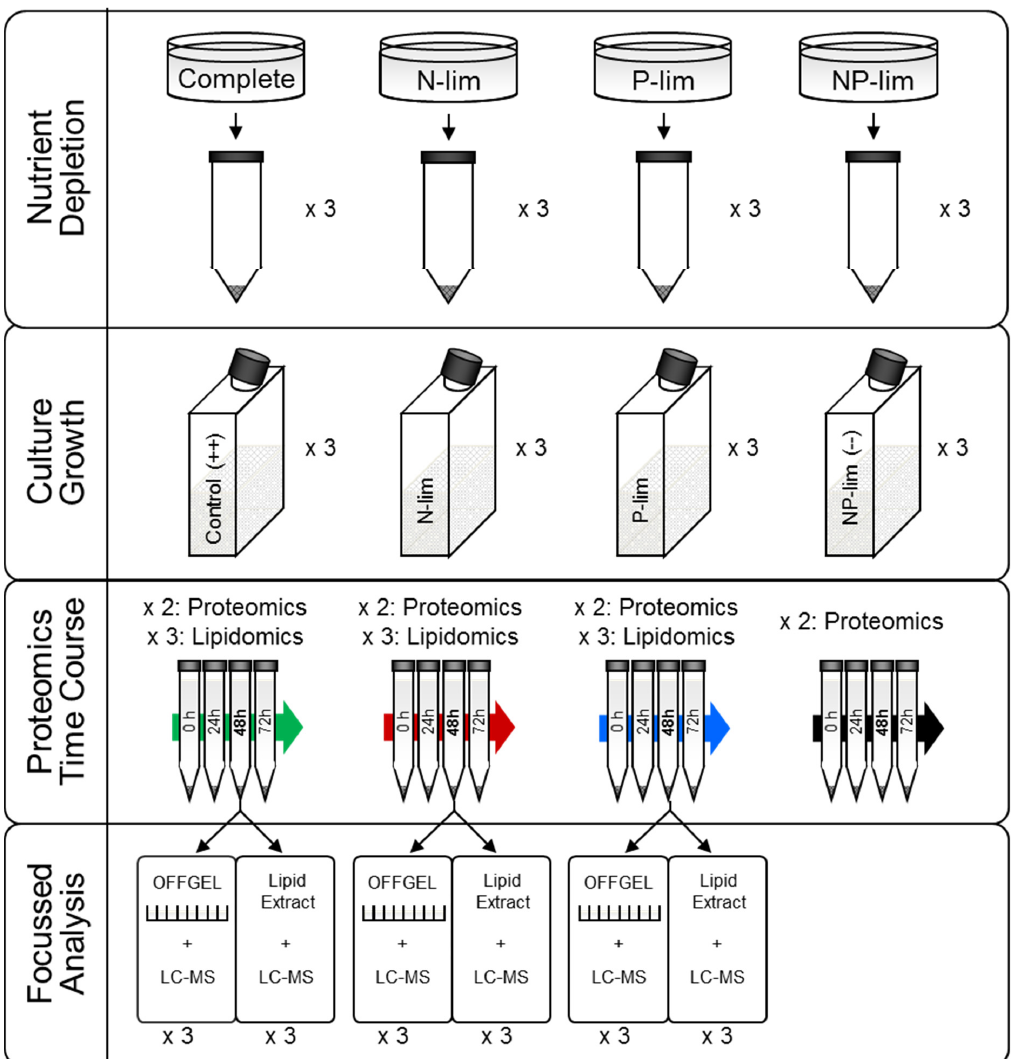
Figure 6. Experimental workflow for proteomic and lipidomic profiling of O. tauri under nutrient stress. Cultures were grown in complete media, media lacking nitrogen sources (N-dep), media lacking phosphorus (P-dep) or media lacking both nitrogen and phosphorous (NP-dep). Algae were sampled at t = 0, 24, 48 and 72 h and shotgun proteomics was performed. The tryptic digests from the 48 h time point were additionally fractionated using OFFGEL isoelectric focusing (IEF) to permit more in-depth characterisation of the O. tauri proteome. Algal samples at this time point were also subjected to lipidomic analysis in order to investigate changes in lipid metabolism.